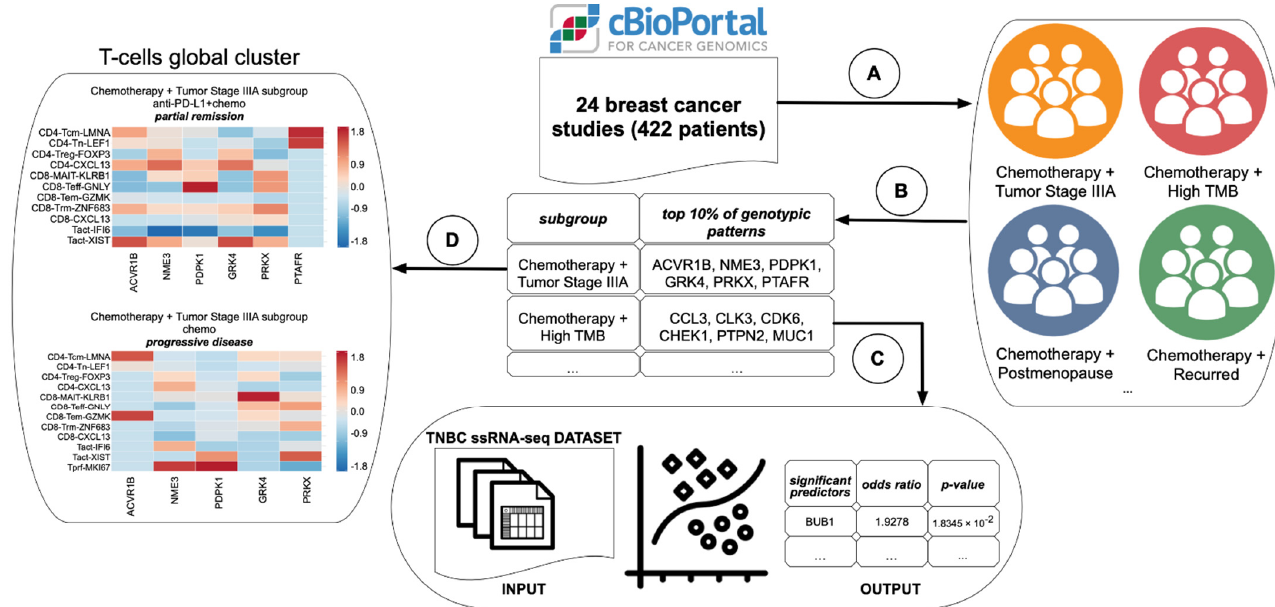
Figure 1. The informatics pipeline. Modules ( A ) and ( B ) – the exploratory subgroup discovery process, Module ( C ) – the inference module based on multinomial regression model, Module ( D ) – immune cell populations discovery.